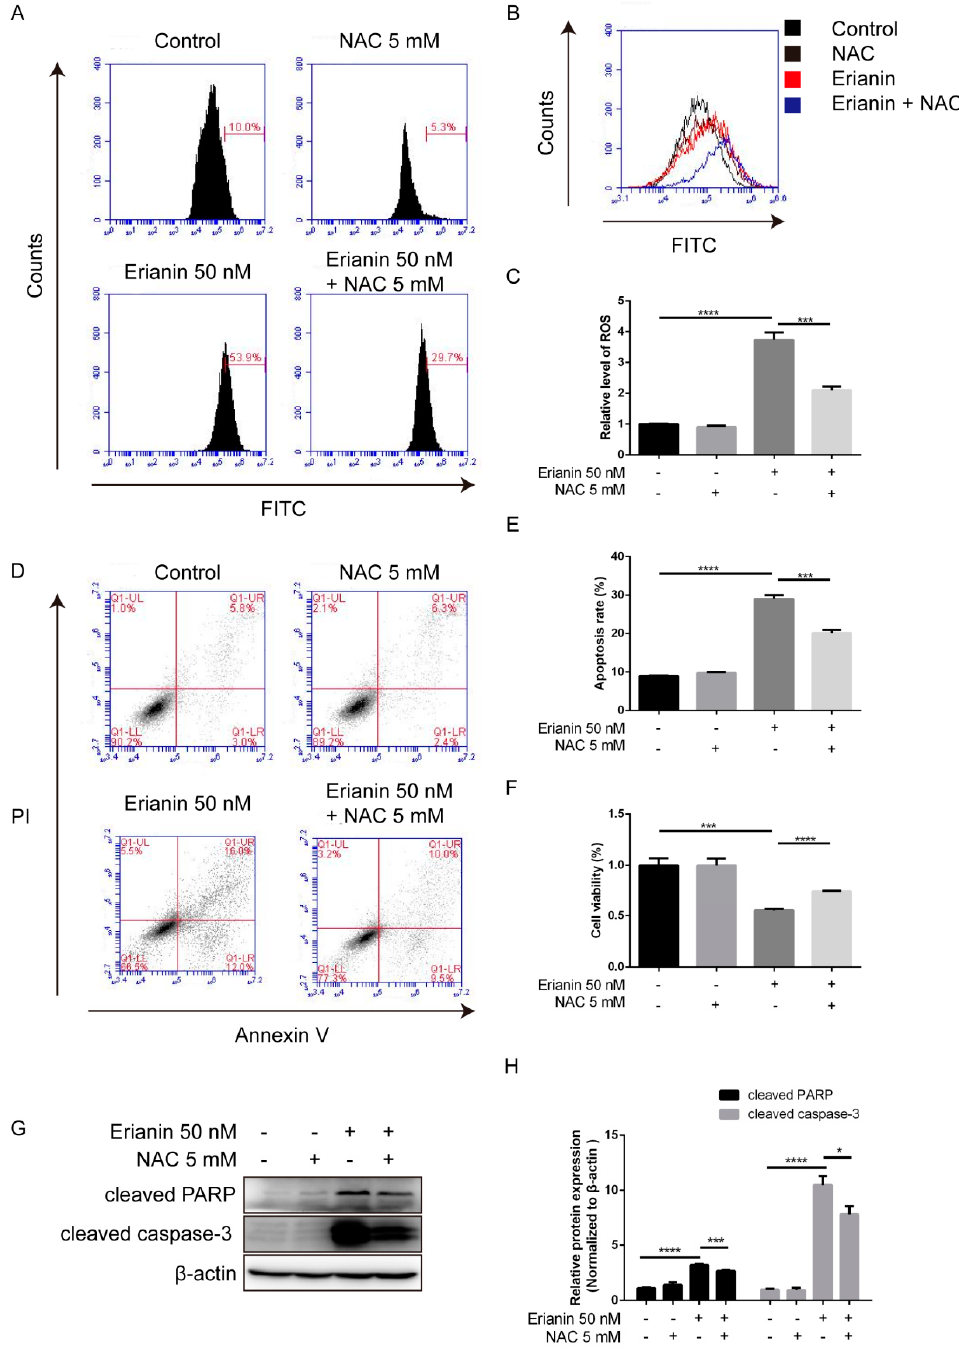
Figure 6. ROS-mediated erianin-induced apoptosis and anti-proliferation in HaCaT cells. Cells were pretreated with 5 mM of NAC for 2 h and then incubated with 50 nM of erianin for 24 h. ( A ) Fluorescence intensity was analyzed by flow cytometry. ( B ) Representative images of ROS production. ( C ) The mean fluorescence intensity was normalized to the untreated group. ( D ) Cellular apoptosis was assayed by Annexin V/PI staining and detected by flow cytometry. ( E ) This histogram shows the statistical apoptosis rate in ( D ). Apoptosis rate = Q1-LR + Q1-UR. ( F ) Cell viability was detected by the MTT assay. ( G ) Western blotting for cleaved PARP and cleaved caspase-3. ( H ) The relative expression intensity of each protein was normalized to the internal control β -actin. The values are expressed as mean ± SD ( n = 3). * p < 0.05, ** p < 0.01, *** p < 0.005, **** p < 0.001, significantly different compared with the untreated group and the NAC-treated group.